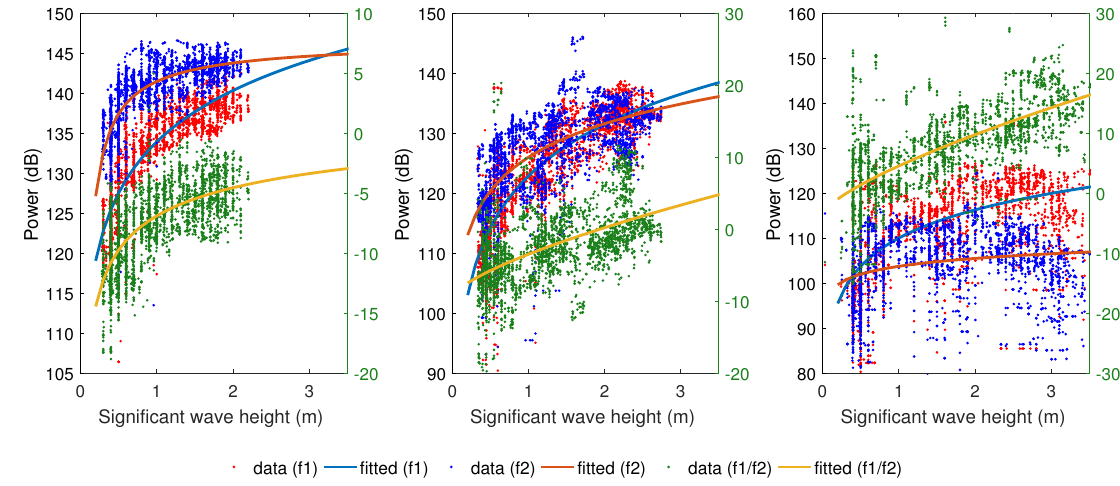
Figure 8. Statistic relationship between wave height and Bragg echo power of single frequency and dual-frequency radar data at different distances: 15 km ( left ), 40 km ( middle ) and 70 km ( right ).